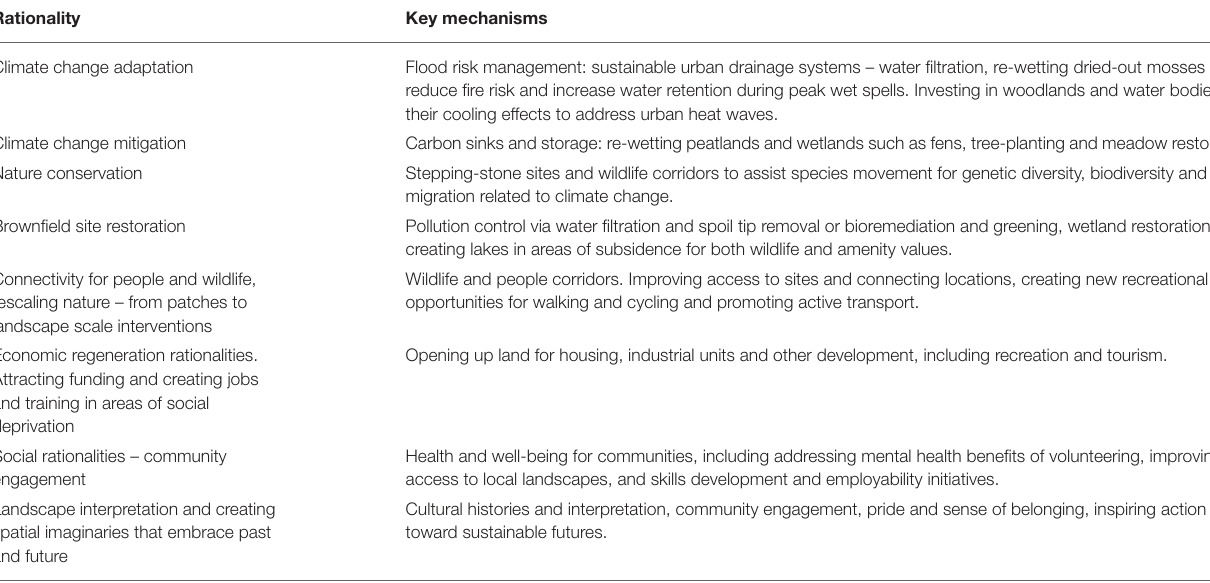
TABLE 1 | Rationalities for investing in urban nature as a form of hybrid infrastructure in North West England. Rationality Key